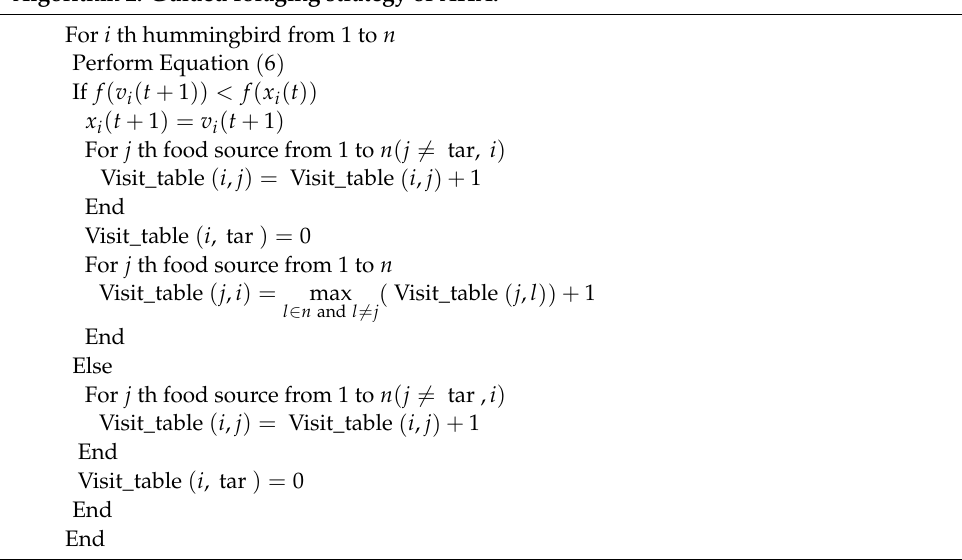
Algorithm 2: Guided foraging strategy of